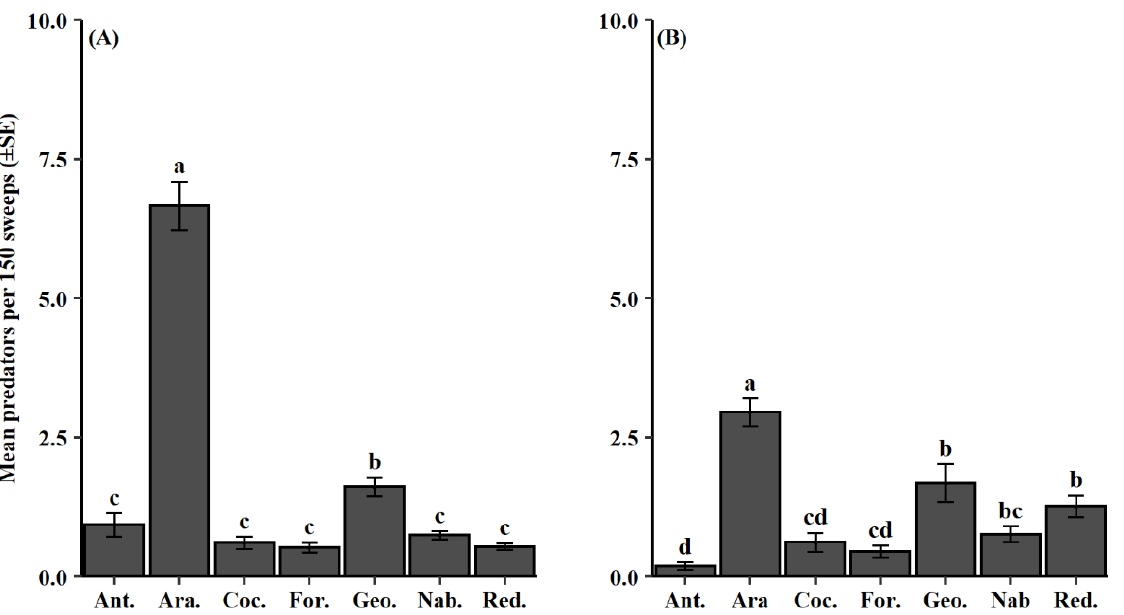
Figure 4. Mean predator count per 150 sweeps ( ± SE) for frequently collected predator groups in datasets ( A ) 2012 – 2014 and ( B ) 2015 – 2018. Same letter denotes no significant difference between means ( p > 0.05). Abbreviations for predator groups are: Ant. = Anthocoridae, Coc. = Coccinellidae, For. = Formicidae, Geo. = Geocoridae, Nab. = Nabidae, and Red. = Reduviidae.